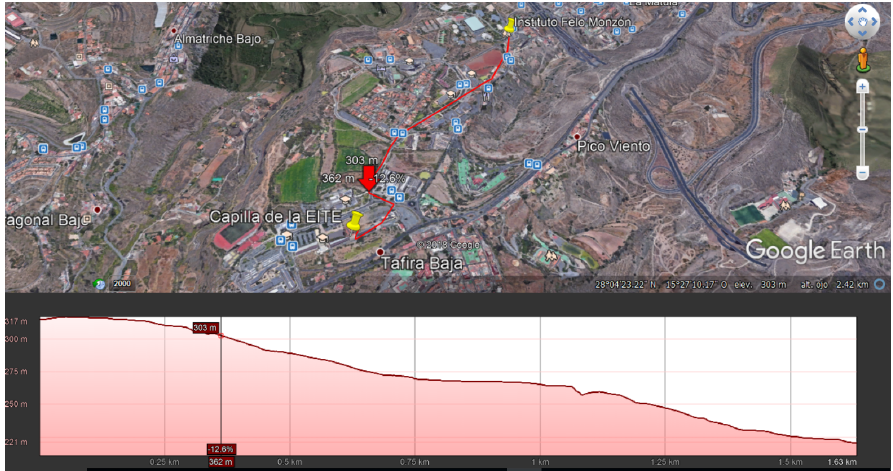
Figure 18. Approximate height profile of the test